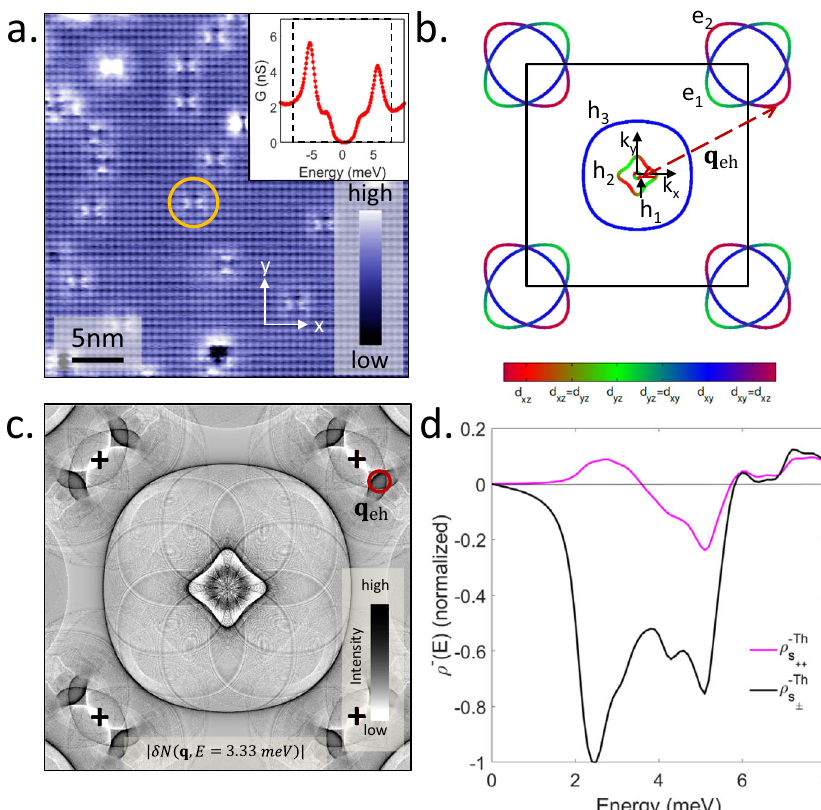
Fig. 3 LiFeAs scattering interference. a Topograph recorded at a LiFeAs surface showing Fe-atom vacancies. The x -axis and the y -axis directions are along As – As directions. The orange circle denotes the type of weak scatterer we chose for our MAHAEM analysis. Inset shows the g ( E ) spectrum measured at a point for superconducting LiFeAs. The dashed rectangle represents the energy limits of the high-resolution d I /d V maps used herein for ρ − ( q , E ) analysis. b The Fermi surface model for LiFeAs showing three hole pockets h 1 , h 2 , and h 3 around Γ -point and two electron pockets e 1 and e 2 around X-point in a 2-Fe zone. The scattering from hole-like to electron-like pockets takes place as indicated by a dashed vector q eh . c Theoretical prediction for single atom | δ N ð q ; E ¼ 3 : 25meV Þ | using band- and gap-structure values fi tted from experiments 18 . The electron-hole scattering near q eh appears as a “ horn ” -shaped feature which is enclosed by a circle. d Theoretical prediction for single atom ρ − ( E ) integrated over the circular region shown in Fig. 3c for both s ± (black) and s ++ (pink)